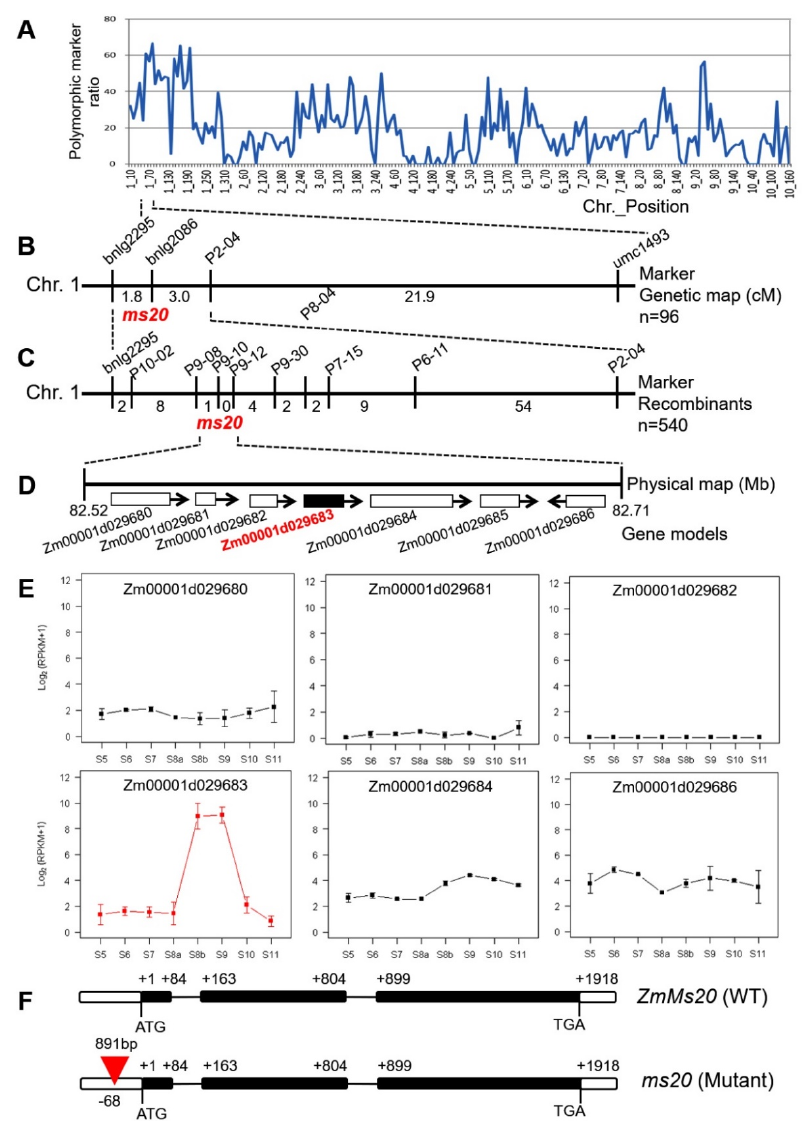
Figure 2. Map-based cloning of maize ms20 gene, expression patterns of six candidate genes, and gene structure of ZmMs20 . ( A ) Polymorphic marker ratio of the sterile plant DNA pool ( ms20 / ms20 ) versus the fertile plant pool ( ZmMs20 / ZmMs20 and ZmMs20 / ms20 ). ( B ) Primary mapping of ms20 locus. The ms20 locus was primarily mapped to the long arm of maize chromosome 1 between Simple Sequence Repeat (SSR) markers bnlg2295 and P2-04; n, the number of F 2 plants used for gene mapping, including 48 male-sterility and 48 male-fertility F 2 individuals. ( C ) Fine mapping of ms20 locus. The ms20 locus was narrowed down to a 190-kb interval between SSR markers P9-08 and P9-12; n, the number of male-sterility F 2 individuals used for fine mapping. ( D ) The seven candidate gene models in the 190-kb interval. Among them, Zm00001d029683 was the IPE1 gene reported previously by Chen et al., 2017 [30]. ( E ) Expression patterns of six of the seven candidate genes in the 190-kb interval based on RNA sequencing data during 8 anther developmental stages (S5 to S11). Zm00001d029685 was annotated as a provisional gene and its expression was not detectable in the RNA sequencing data, whereas Zm00001d029683 was found to be high expression at both stages 8b and 9. ( F ) Gene structure of ZmMs20 and DNA sequence mutation of ms20 . ZmMs20 consists of three exons and two introns. The +1 indicates the starting nucleotide site of translation, and the stop codon (TGA) is +1918. Black boxes indicate exons, and intervening lines indicate introns. An 891-bp insertion at the -68 bp site of the 5 (cid:48) UTR was found in the ms20 mutant, and shown in a red